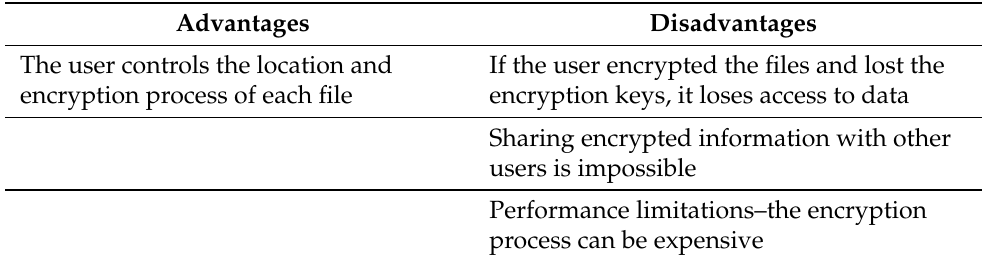
Table 1. Advantages and disadvantages of standalone cloud storage.